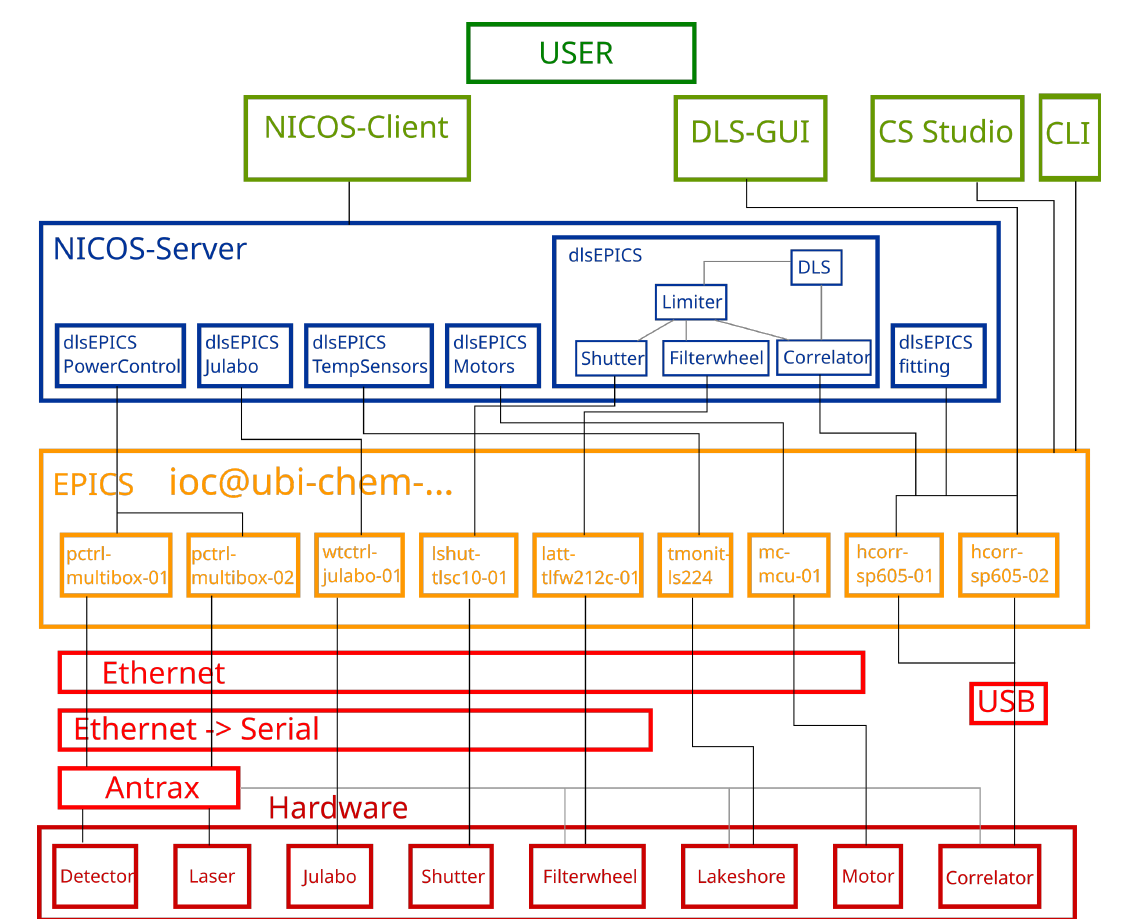
Figure 8. Schematic representation of the architecture of the setup. The user can interact via the NICOS client with the NICOS server [42,43], where the measurements are controlled. Low level-control of the devices is implemented via EPICS, that is connected via different protocols to the hardware. Alternatively, the EPICS process variables can be directly manipulated via the program CS Studio or the command line interface